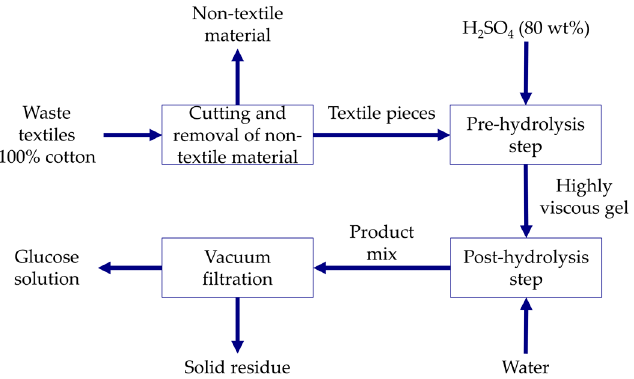
Figure 1. Schematic of the two-step textile hydrolysis process using different concentrations of sulfuric acid.